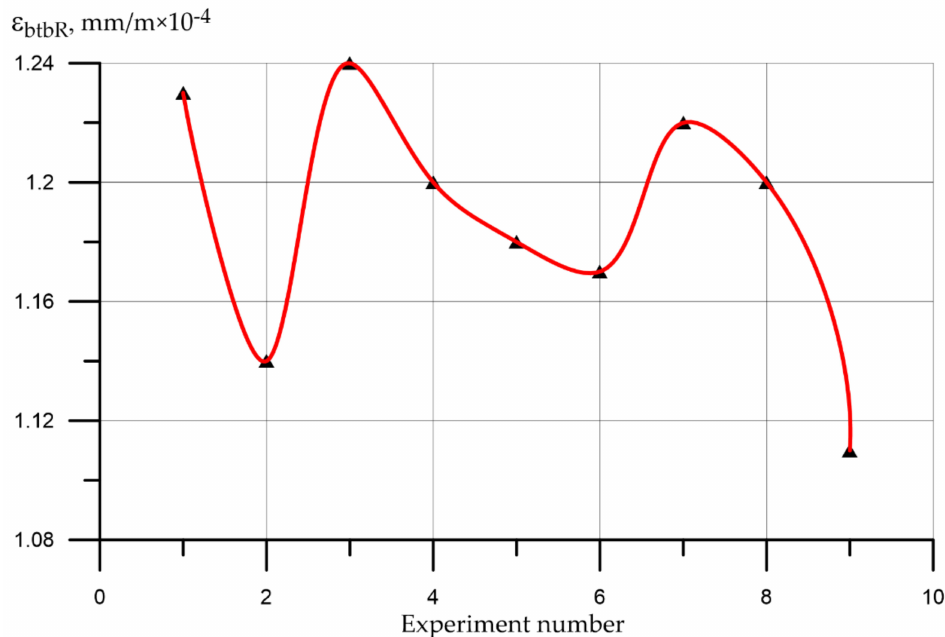
Figure 11. Changes in the ultimate deformations during the axial tension of LFRC on a combined aggregate, depending on the volumetric content of fiber-reinforced concrete and the method of its distribution when preparing a fiber-reinforced concrete mixture.